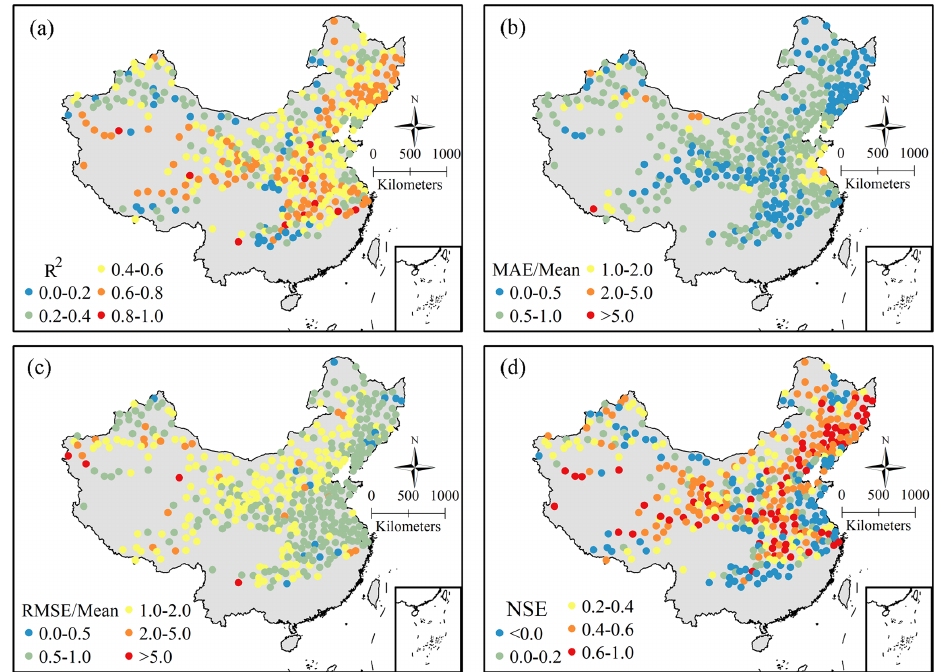
Figure 3. Statistical criteria of the calculated snowfall against observed snowfall at 457 meteorological stations in China. Panel (a) shows the R 2 (coefficient of determination). Panel (b) shows MAE / Mean, where MAE is the mean absolute error, and Mean is the monthly mean snowfall. Panel (c) shows RMSE / Mean, where RMSE is the root mean square error. Panel (d) shows the NSE (Nash–Sutcliffe